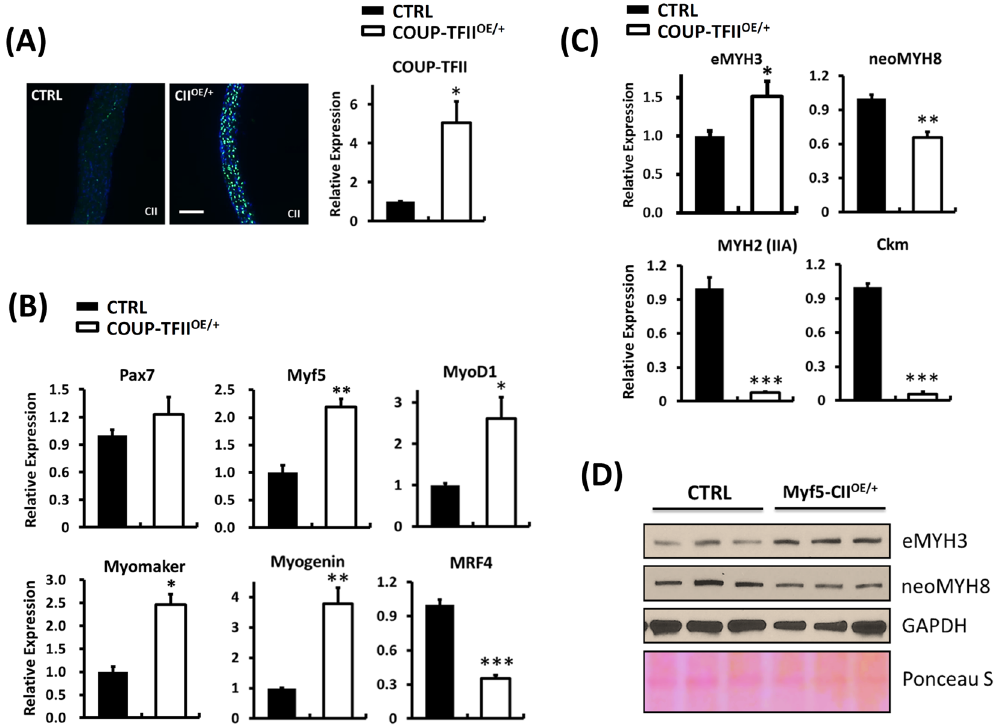
Figure 4. COUP-TFII overexpression inhibits diaphragm skeletal muscle maturation. ( A ) Immunofluorescence staining and quantitative RT-PCR examination of COUP-TFII protein and mRNA expression in the diaphragm. Quantitative RT-PCR examination of ( B ) Pax7, Myf5, MyoD1, Myomaker , Myogenin and MRF 4 ( C ) embryonic (e MYH3 ), neonatal (neo MYH8 ) and adult ( MYH2 , IIA) myosin heavy chain, Ckm mRNA expression in the diaphragm muscle of control and My5-COUP-TFII OE/ + fetus. Total RNA was extracted using TRIzol ® reagent. ( D ) Western blot analysis of myosin heavy chain protein expression, eMYH3 and neoMYH8, in the diaphragm muscle of control and My5-COUP-TFII OE/ + fetus. Protein was extracted using 0.1% SDS-RIPA buffer. Diaphragm muscle was dissected from E18.5 fetus and tissues were homogenized using a polytron homogenizer. Data are shown as mean ± SEM. Two-tailed Student's t test; * p < 0.05, ** p < 0.01, *** p < < 0.001, compared to control